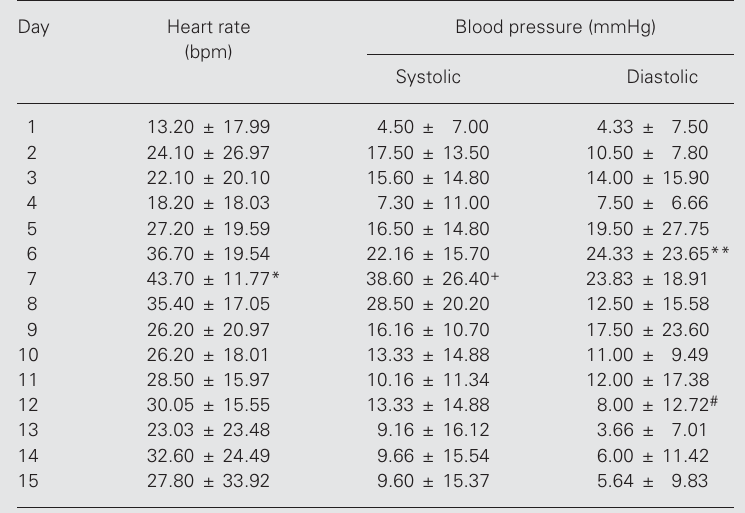
Table 1. Heart rate and blood pressure changes in children with severe tetanus and autonomic